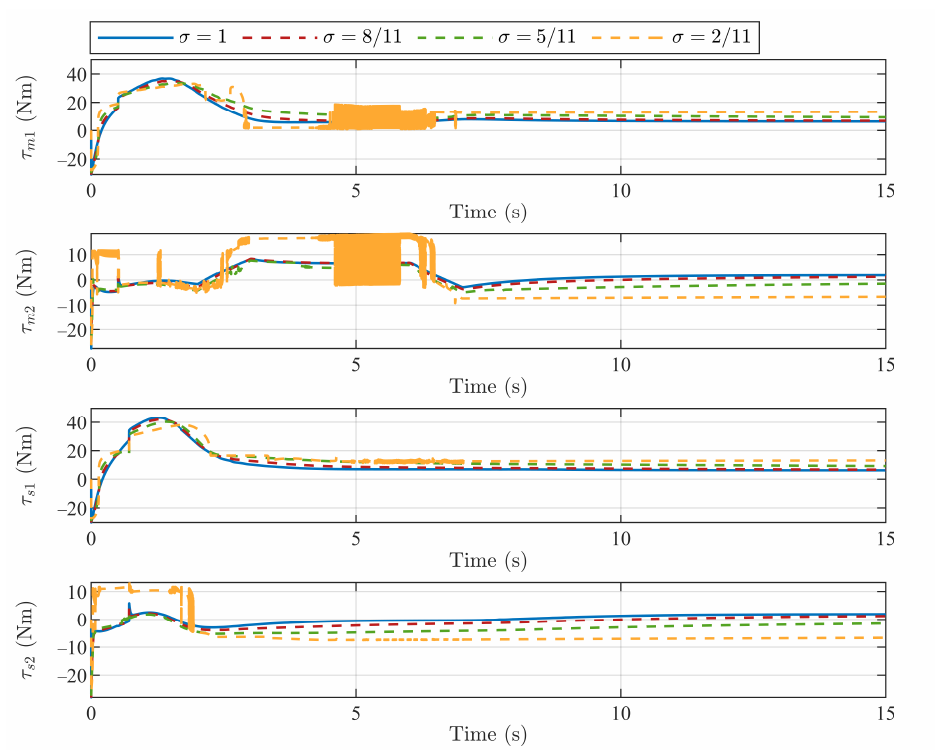
Figure 11. Control torques for the master and slave robots with different values of σ